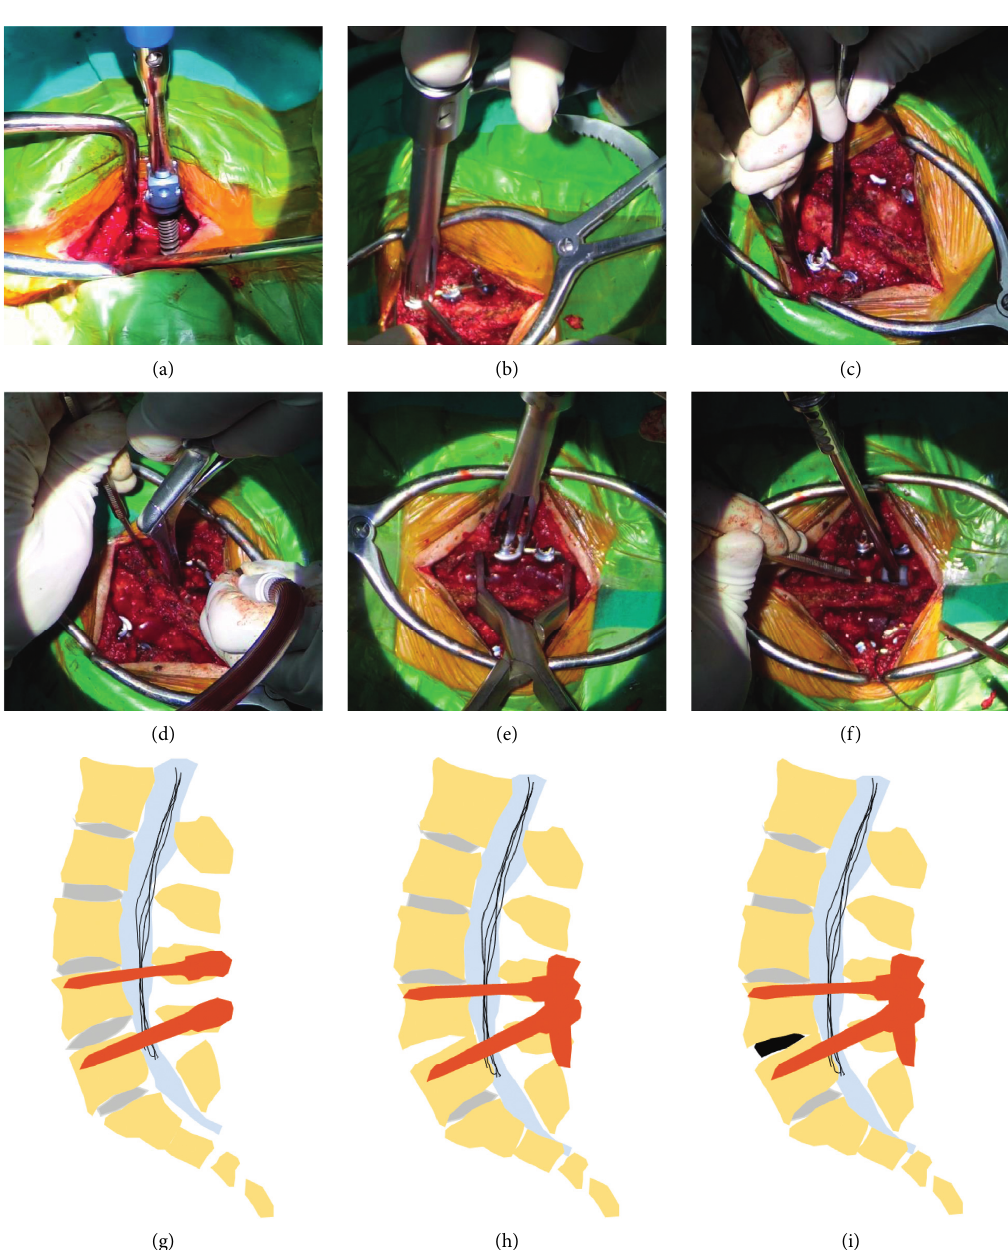
Figure 1: Representative intraoperative images of CLIF: (a) position of surgical segment; (b) insertion of ipsilateral pedicle screws and rods; (c) insertion of contralateral pedicle screws and rods; (d) removal of the disc tissue and partial cartilage endplate; (e) slow axial compression of the operated segment; (f) insertion of the intervertebral cage; (g) insertion of the pedicle screws; (h) installation of the rods prior to the placement of cages; and (i) axial compression of the segment after insertion of the cage. CLIF: transforaminal lumbar interbody fusion with spine